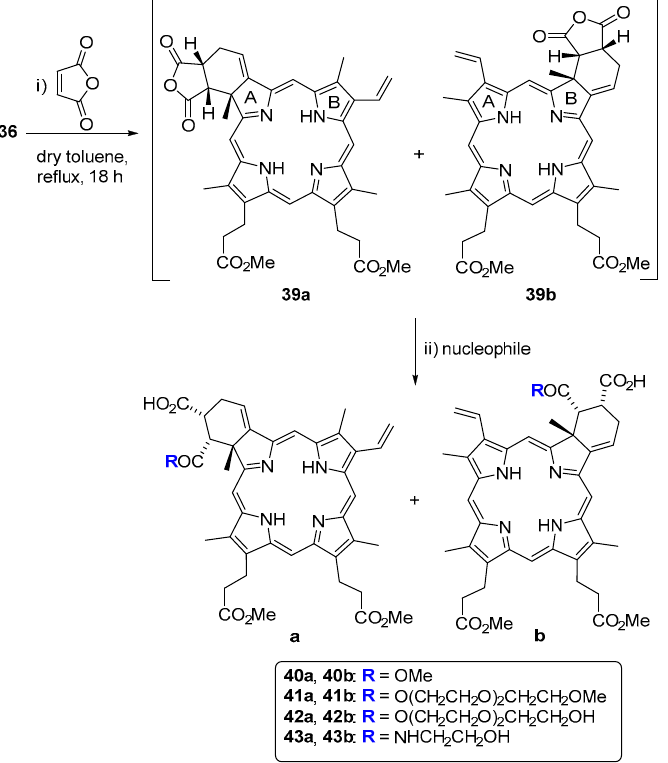
Scheme 13. Synthesis of amphiphilic chlorin derivatives [126].